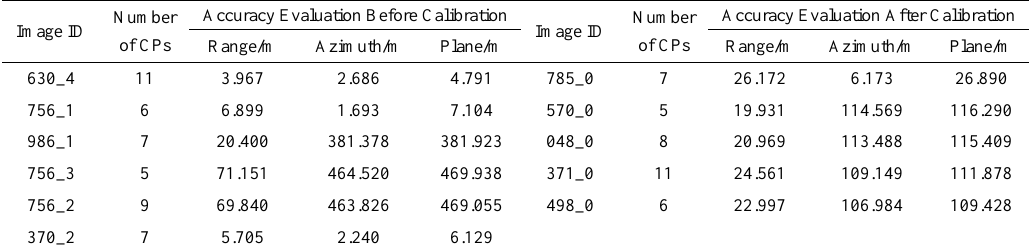
Table 2. Accuracy evaluation of study images before the geometric